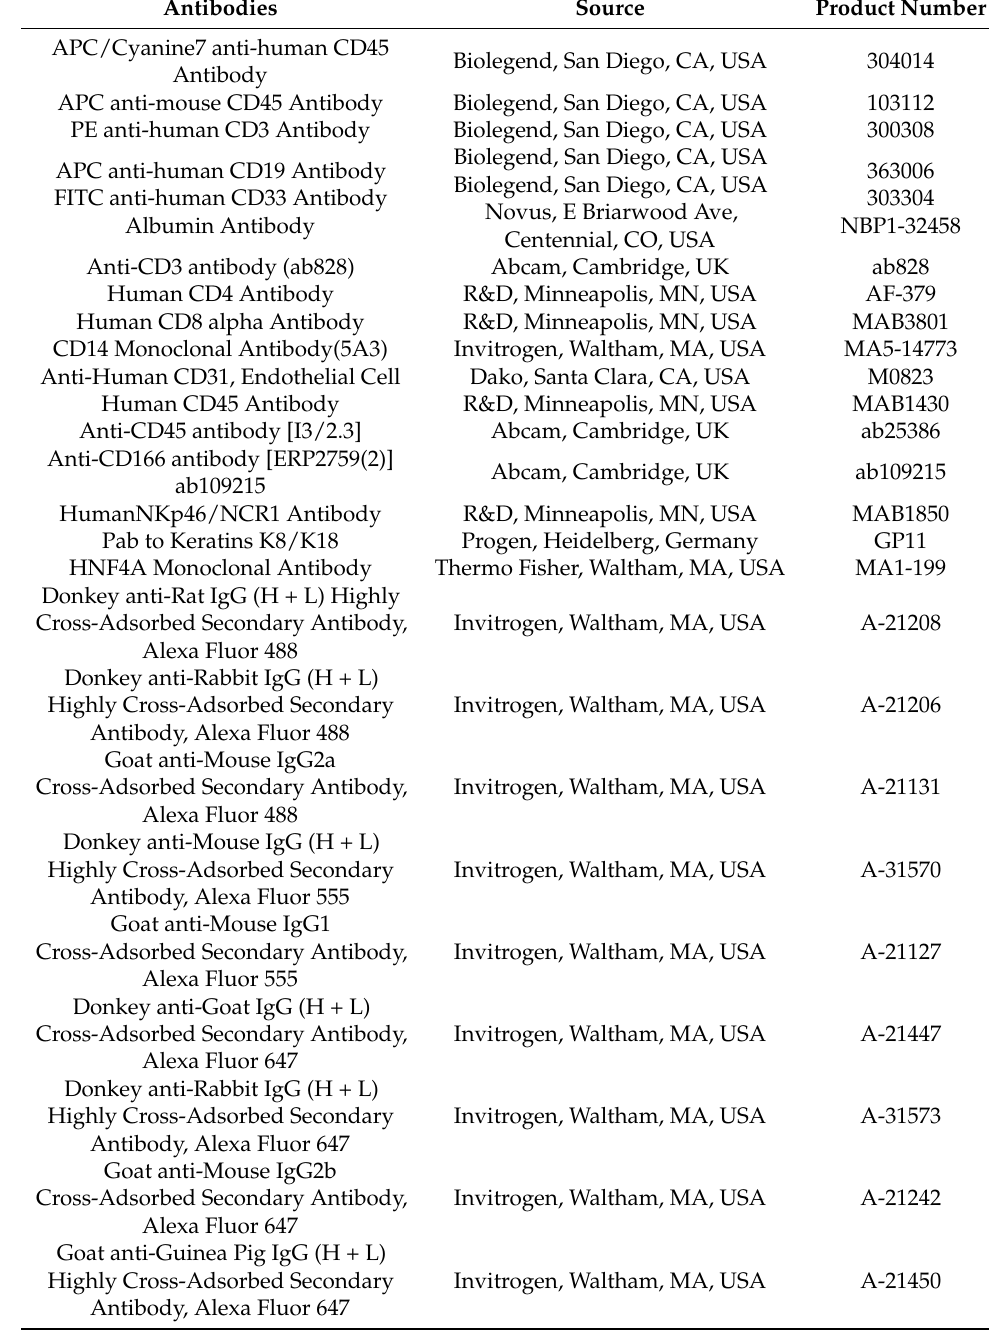
Table 1. Antibodies used in the